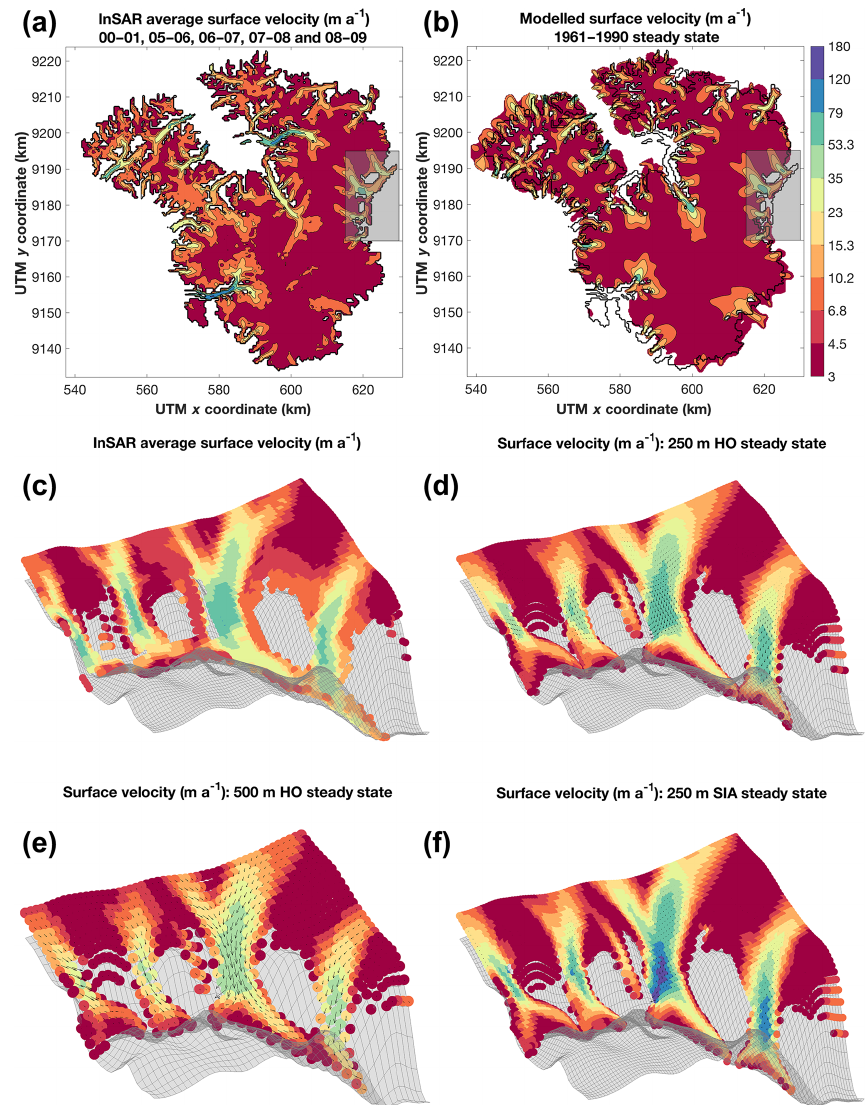
Figure 7. (a) InSAR-derived surface velocities (Joughin et al., 2010, 2015) and (b) 1961–1990 steady-state surface velocities (250m HO run). Black lines represent the observed ice cap outline from the Starzer and Reeh (2001) DEM; the shaded box delineates the area shown in (c, d, e, f) . (c) InSAR-derived surface velocities, (d) 250m HO surface velocities, (e) 500m HO surface velocities and (f) 250m SIA surface velocities. For the InSAR velocities (c) the geometry corresponds to the observed one (Starzer and Reeh, 2001), while for the model runs (d, e, f) the geometry corresponds to the steady-state geometry. Notice that for the model runs the SMB is fixed in time (1961–1990 climatology applied on the present-day geometry) in order to avoid effects related to the SMB–elevation